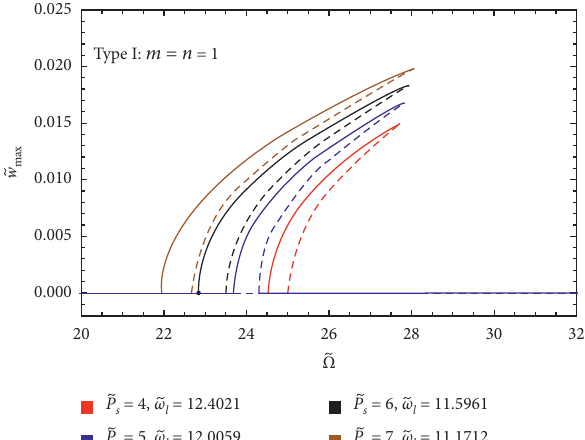
Figure 7: The effect of 􏽥 P s on the transverse motion of type I BDFG beam with m � n � 1, L / h � 20, 􏽥 c d � 􏽥 c r � 0 . 05, and P d � 1 .